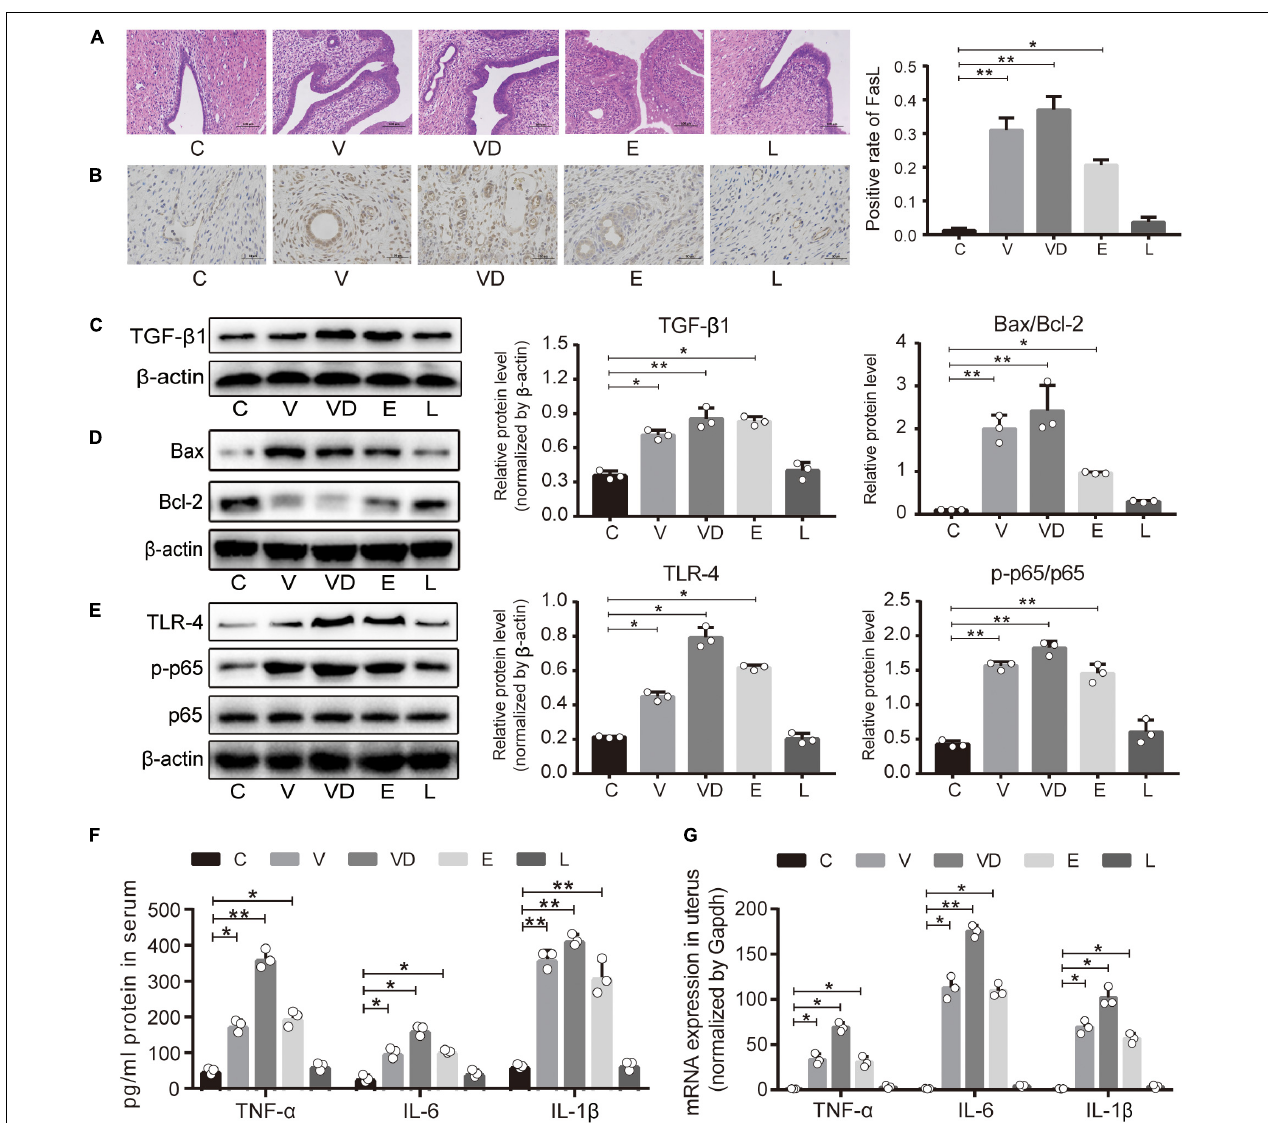
FIGURE 4 | Treated vagina with L. crispatus had no influence on uterine impairment and vaginal inflammation. (A) Uterine histopathological examination was performed by H&E staining with different treatments; the bar represents 100 µ m. (B) The immunohistochemistry images (left) of FasL expression were determined in the uterus from the indicated treatment groups; the graph on the right shows a positive rate counted in at least five different areas in the images; the bar represents 50 µ m. The relative expression of (C) TGF- β 1, (D) Bax/Bcl-2, and (E) TLR-4/NF κ B was analyzed by western blotting in the vagina. (F) ELISA-based quantification of TNF- α , IL-6, and IL-1 β levels in serum from the indicated treatment groups. (G) The mRNA expressions of TNF- α , IL-6, and IL-1 β were determined by qPCR in the uterus. The data represent means ± SD of three independent experiments. * P < 0.05, ** P < 0.01. SD, standard deviation; C, control; V, VNP20009; VD, VNP20009 DNase I; E, E. coli O157:H7; L, L. crispatus